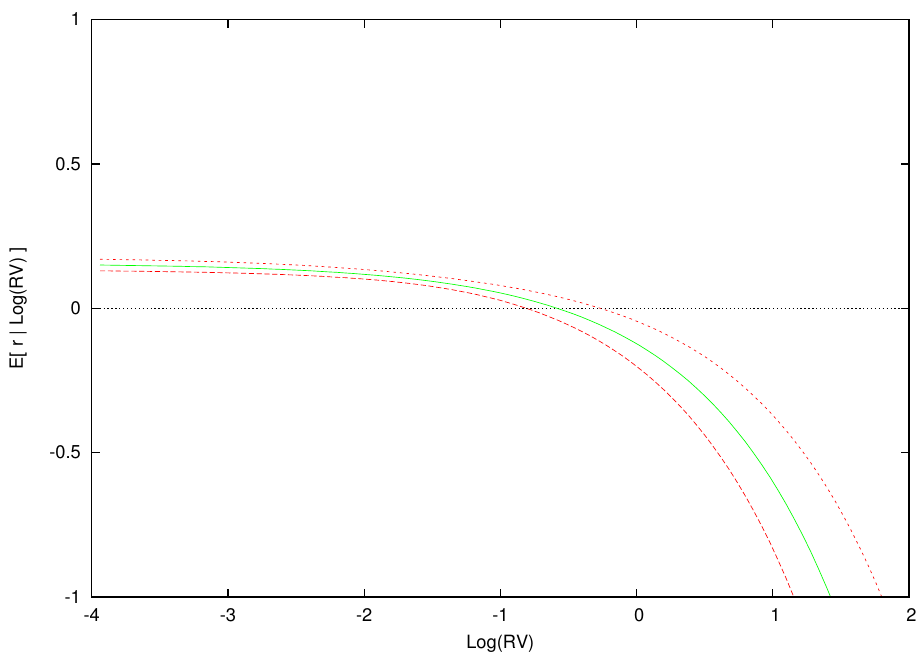
Figure 2. Expected excess return given log realized variance for the parametric model. This figure displays the expected excess return and 0.90 density intervals as a function of log realized variance for the parametric